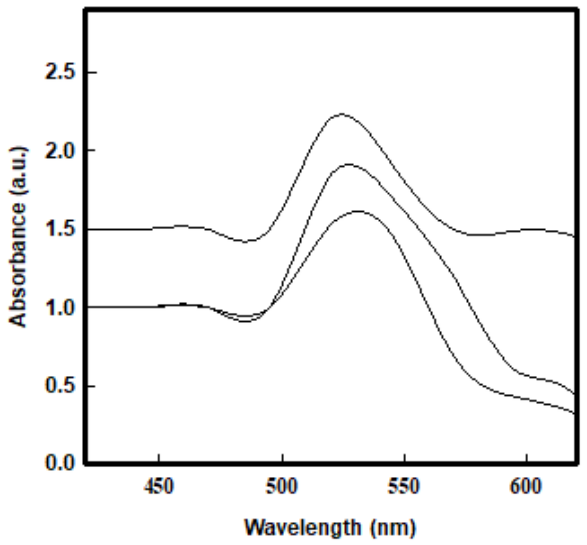
Figure 2. Room temperature UV–Vis absorption spectra of selenium nanoparticles (SeNPs). The arrow indicates the increasing trend of SPR (Surface Plasmon Resonance) bands at an incubation of 24, 48, and 72 h.